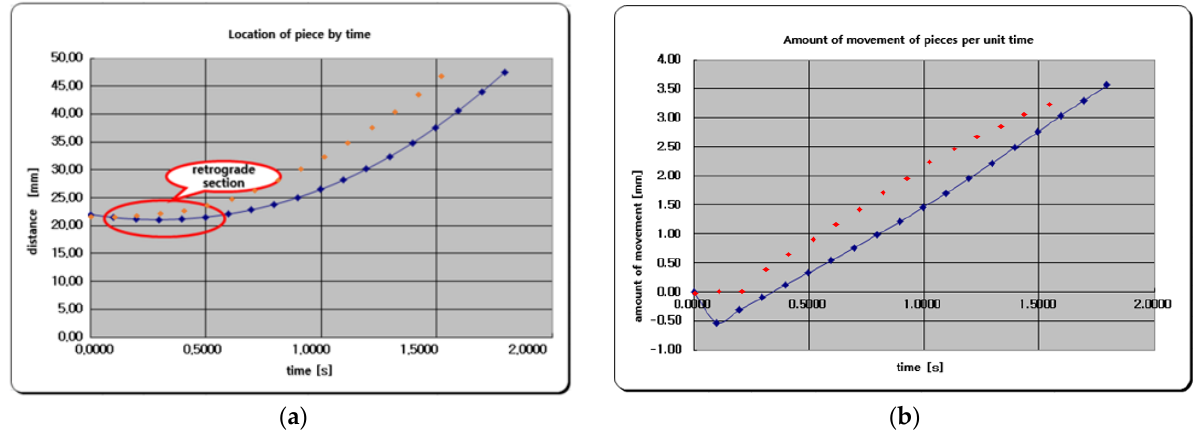
Figure 9. When the normal (orange) and spline (blue) curve of the slide plate rail was 20 degrees at a constant speed: ( a ) Location of piece over time; ( b ) Amount of movement of pieces per unit time.